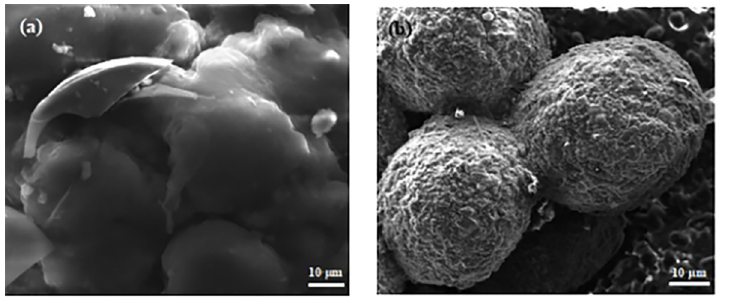
Fig 13. SEM images of ZPC particles. (a) Image before the adsorption reaction; (b) Image after the adsorption